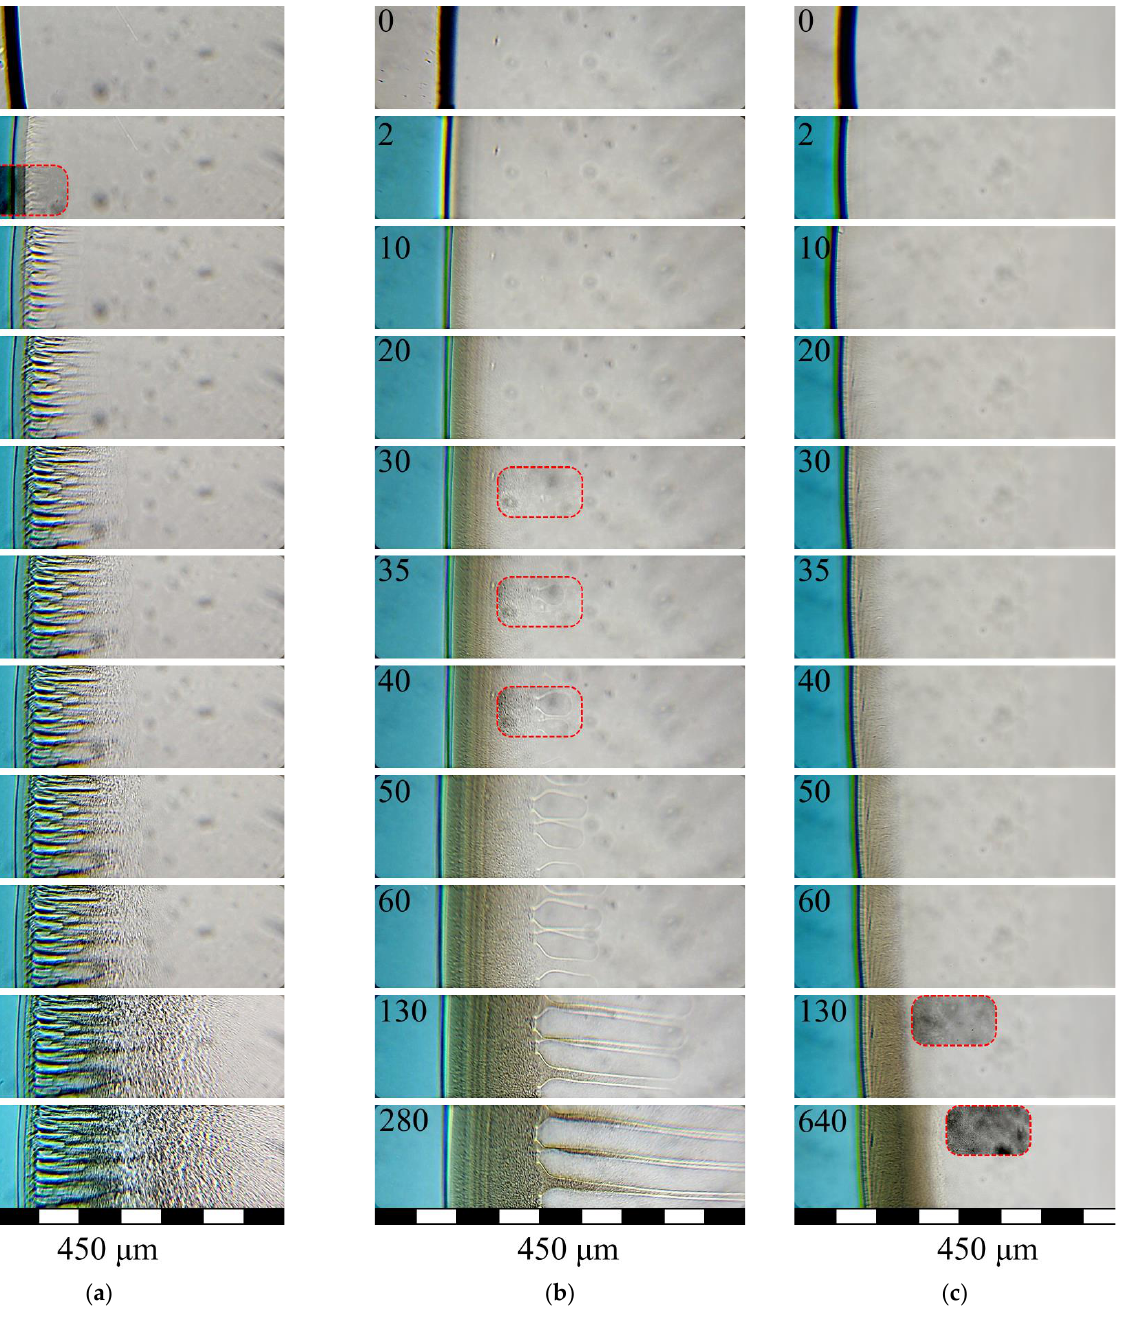
Figure 5. Photographs illustrating the evolution of the structure of PLGA/TG mixtures containing ( a ) 10, ( b ), 20, and ( c ) 30 wt.% polymer upon their contact with a precipitator (stained water). Indicated in the top left corner of each photograph is the time lapsed after the sample mixture came into contact with the precipitator. In the regions delimited by the red dashed lines, the contrast of the image is increased and the brightness is decreased for better visual perception.